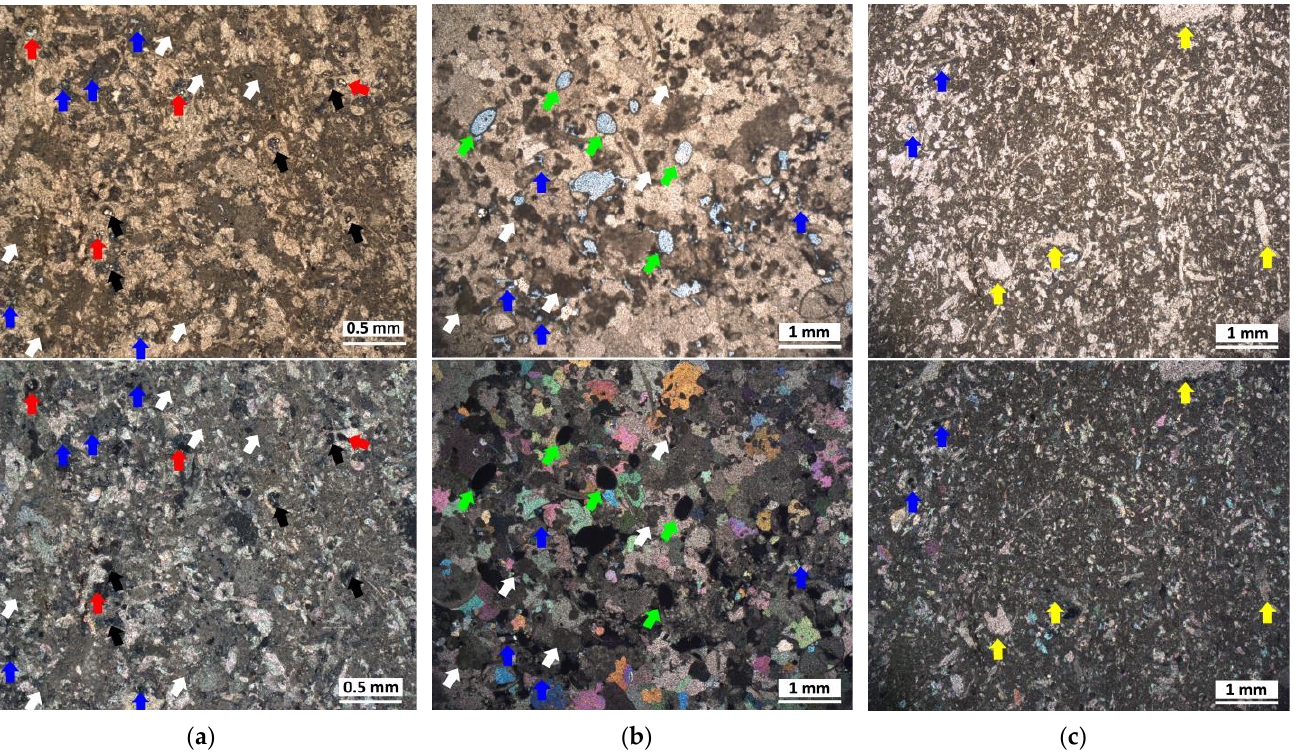
Figure 3. Images of thin sections of ( a ) Samples 1, ( b ) Sample 2, ( c ) Sample 3 (one half of the figure is in plane polarized light (PPL) and the second half of the figure is in cross polarized light (XPL)). Peloids are shown by white arrows, foraminifera are indicated by black arrows, fragmented grains of crinoids are indicated by yellow arrows, intragrain types of porosity are indicated by red arrows, intergrain types of porosity are shown as blue arrows, and separate-vug pore space is indicated by green arrows.